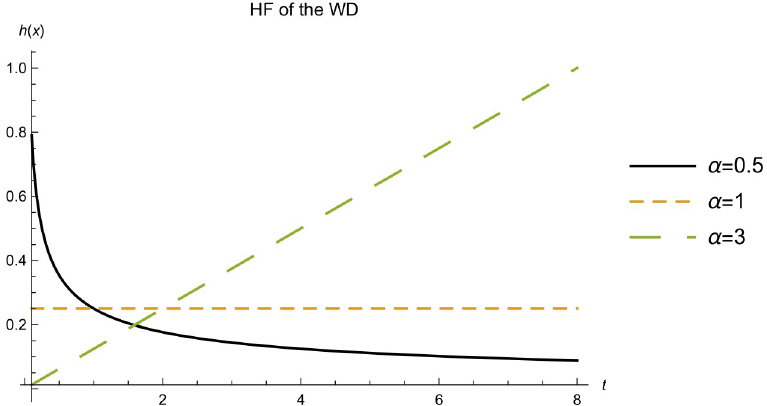
Fig 2. HF of the WD. The HF of the WD with scale parameter β = 4 and different values for the shape parameter α .